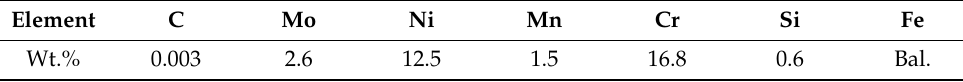
Table 1. Chemical composition of AISI316L stainless steel powder.